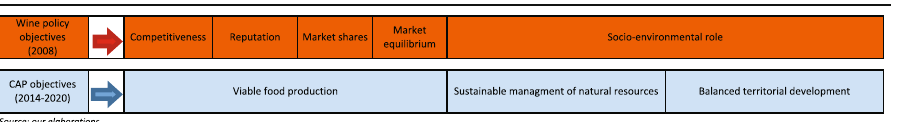
Table 2 CAP and wine policy objectives: a